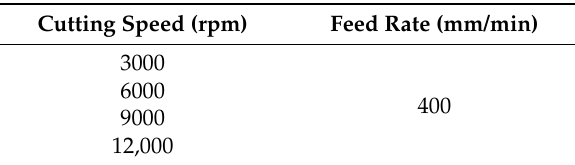
Figure 1. Experimental setup: ( a ) profile and geometrical parameters of two-flute twist drill; ( b ) CFRP plate clamping arrangement (Makino A-55). Table 2. Sets of drilling parameters.